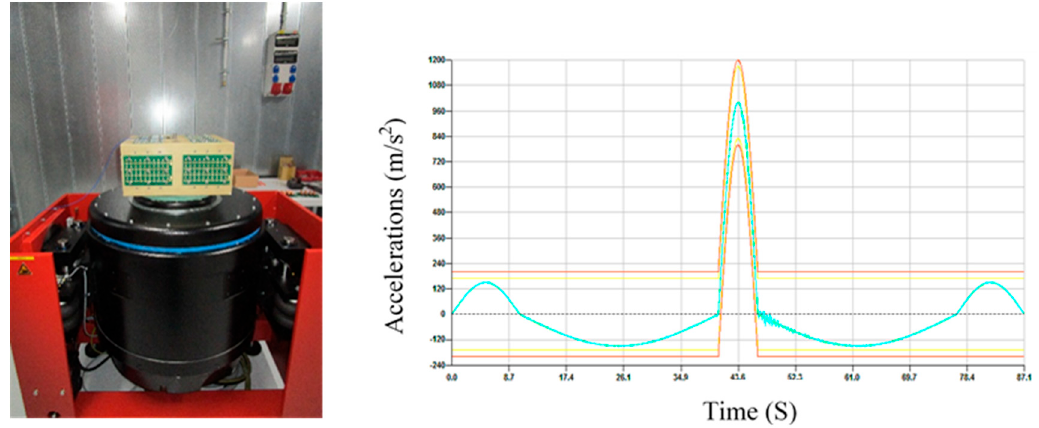
Figure 14. Mechanical Shock on PCB. ( a ) Testing equipment ( b ) Mechanical shock profile where the green line indicates the mechanical shock profile performed, and the other one shows the limits.